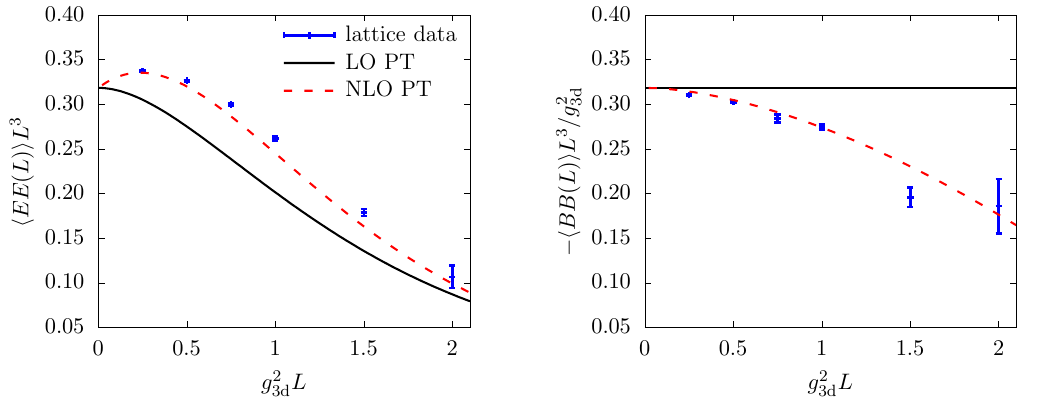
Figure 2 . Continuum-extrapolated h EE i L 3 (left) and −h BB i L 3 /g 2 perturbative (LO PT), next-to-leading-order perturbative (NLO PT), and lattice data at T = 100 GeV and N f = 5 (cf. table 1). Correlators are multiplied by ( g 2